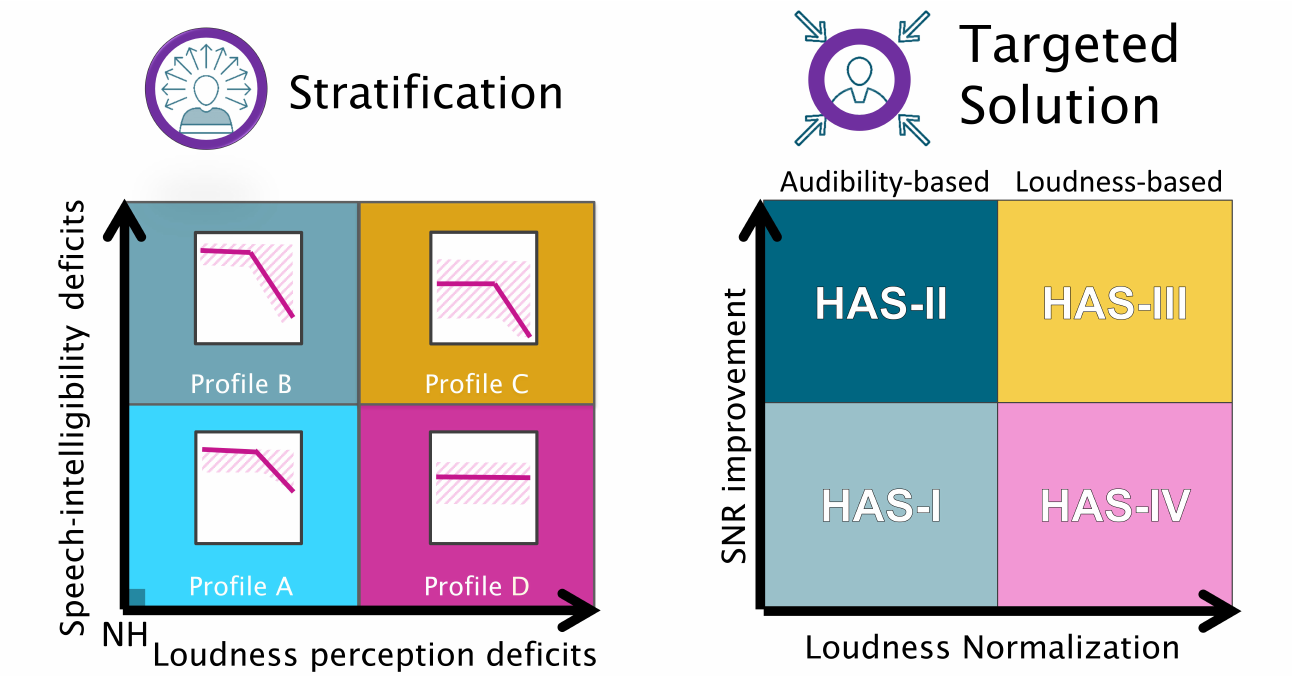
Figure 1. Illustration of the profile-based HA fitting strategy. Left: summary of the results of the auditory profiling [7]. In a two-dimensional space with speech intelligibility-related (SI) deficits on one axis and loudness perception-related (LP) deficits on the other axis, listeners differing in the degree of the two types of perceptual deficits are placed at different positions along the two dimensions. While Profile C represents a high degree of both types of deficits, Profiles B and D reflect hearing deficits dominated by one deficit type only. Profile A has a low degree of deficits and, thus, near-normal hearing abilities. Each dimension covaries with specific deficits observed on a number of behavioral tasks that define a given auditory profile. Right: proposed candidate hearing-aid settings (HAS) for the different profiles, which are intended to compensate for the specific auditory deficits. Signal-to-noise ratio (SNR) improvement as a hearing solution for SI deficits and loudness normalization as a solution for LP